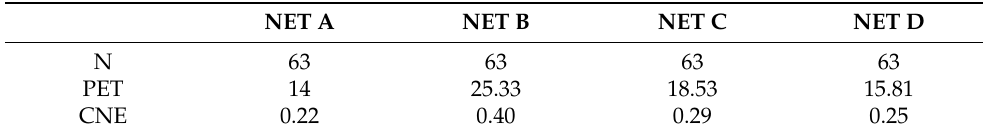
Table 3. Network potency factor of four network